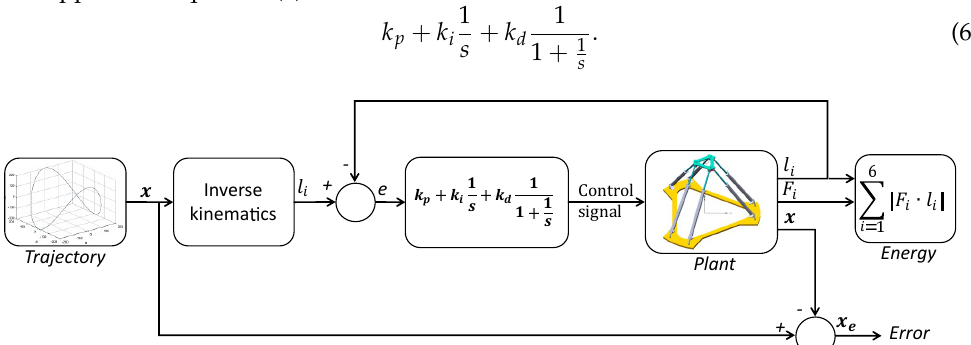
Figure 4. Proportional Integral Derivative (PID) control scheme of the lengths. It is used for the error and energy